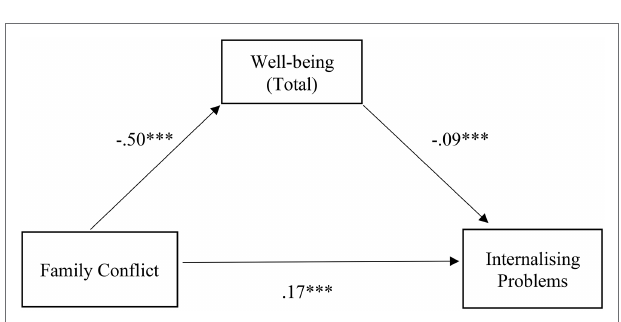
FIGURE 2 | Illustration of the direct effects of the family conflict for internalizing problems through the mediator well-being. The represented coefficients are standardized. Total effect ( β = 0.21, p < 0.001). *** p < 0.001.